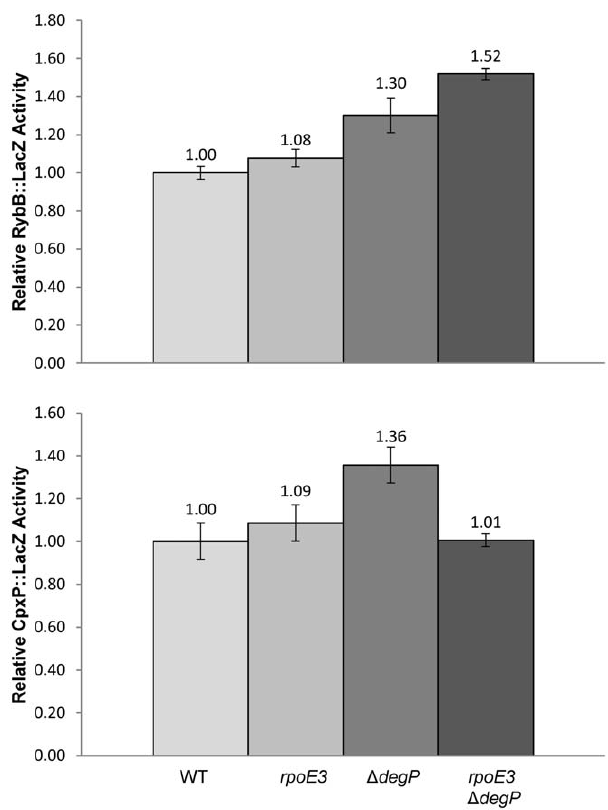
Figure 6. Effects of D degP and rpoE3 mutations on RybB::LacZ (A) and CpxP::LacZ (B) activities. For each strain, two independent cultures were grown at 39 u C to a mid-log phase and used for b - galactosidase assays. LacZ activities are relative to the wild-type strain. The relevant genotypes of the strains are labeled at the bottom.